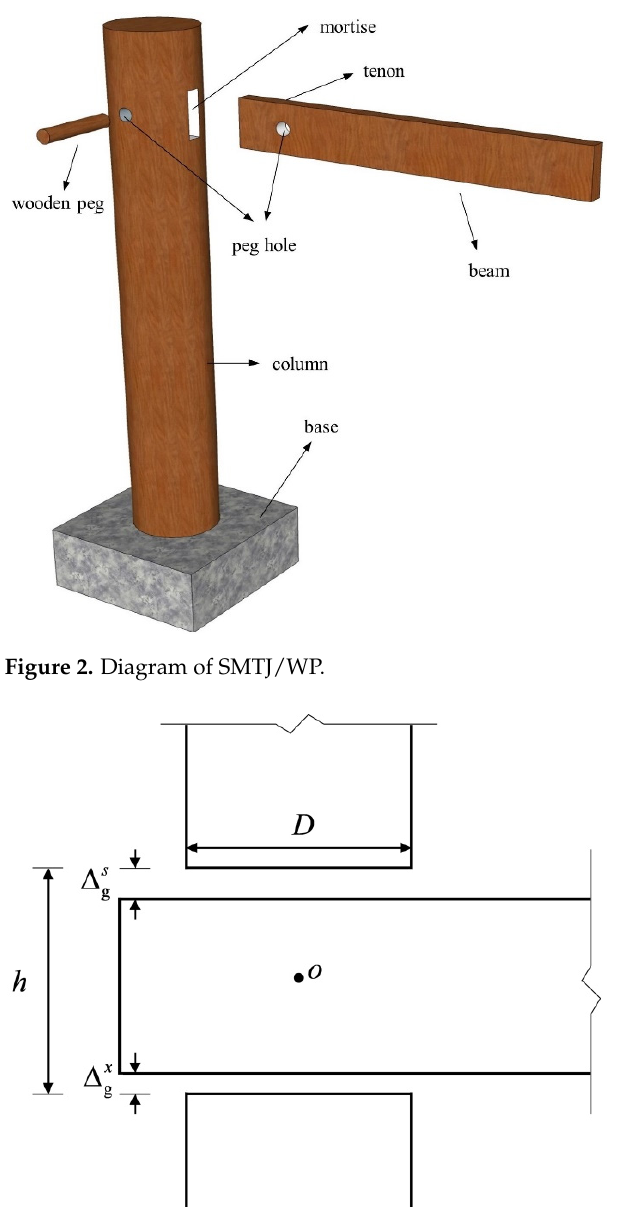
Figure 3. The detailed dimensions of the SMTJ/WP. Note: ∆ s g and ∆ x g are the gaps between the upper and lower surfaces of the tenon and the mortise, respectively; D is the diameter of the column; h is the height of the mortise.